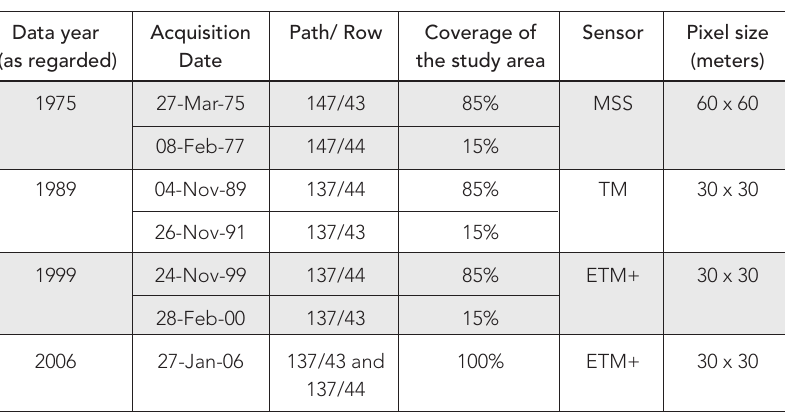
Table 1: Particulars of collected Landsat images from the USGS archive Data